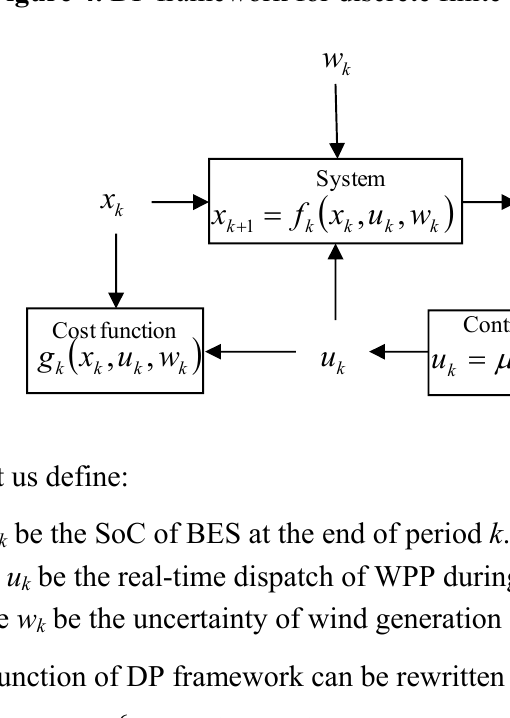
Figure 4. DP framework for discrete finite state